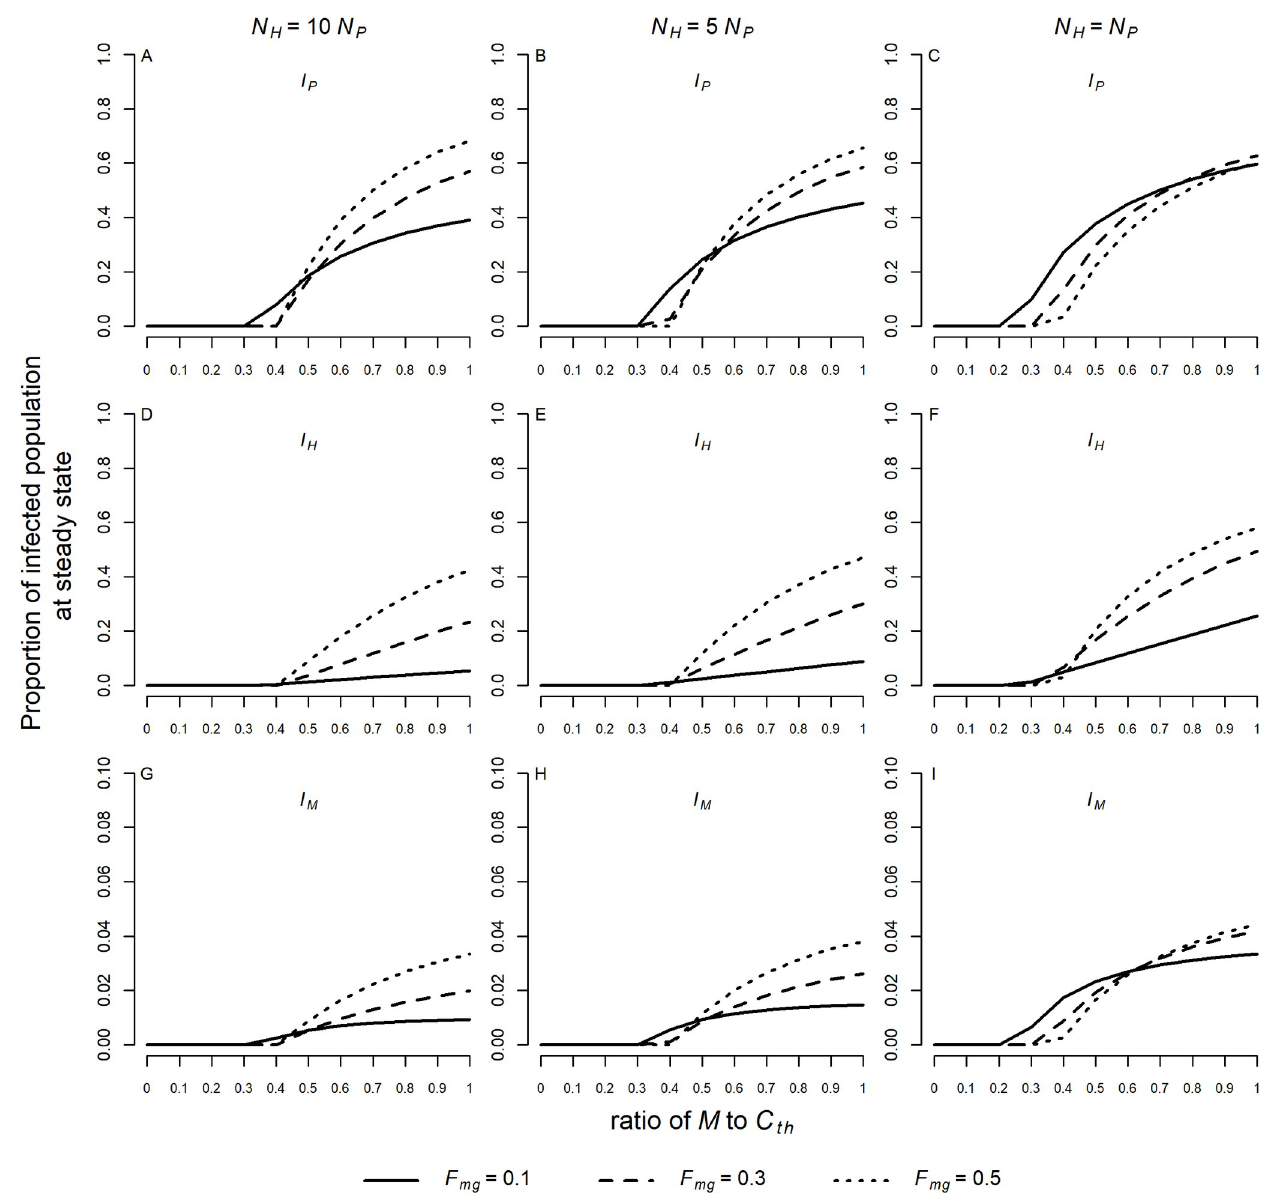
Fig 2. Proportions of infected individuals at steady state in the monkey (A, B, C), human (D, E, F), and mosquito (G, H, I) populations. Simulations were performed for a ratio of M to C varying from 0.01 to 0.99 and for F = 0.1, 0.3 and 0.5. Three different scenarios were considered: N = 10 N (A, D, th mg H P G), N H = 5 N P (B, E, H), and N H = N P (C, F, I). The following values were assumed to simian parameters: τ = 0.0044, T MP = 0.034, and T PM = 0.428 when N H = 10 N ; τ = 0.0044, T = 0.029, and T = 0.342 when N = 5 N ; τ = 0.0038, T = 0.026, and T = 0.261 when N = N . The values of the other P MP PM H P MP PM H P parameters used in the model were fixed: C th = 20( N H + N P ), C ¼ ð C (cid:0) M Þ 1 ; C ¼ C , μ = 0.8, γ = 0.0035, T MH = 0.022, T MP = 0.044, T HM = 0.24, b = 0.5, c th g c 2 h = 20, B c = 0 and B g =